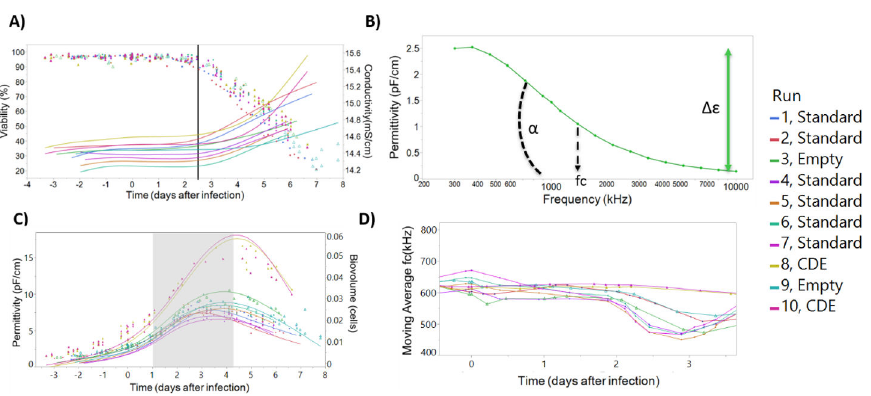
Figure 4. Incyte measurements can be correlated with the progress of baculovirus infection in insect cells. ( A ) The onset of baculovirus-induced cell lysis (viability, represented with circles) can be detected by the simultaneous onset of conductivity increase (smooth lines, measured by Incyte). ( B ) Beta-dispersion curve 24 h after seeding, for batch number 1. The beta-dispersion allows calculation of variables such as ∆ ε , α , and characteristic frequency, which are indicative of the cell state during the infection process. ( C ) Visual inspection of the permittivity profile allows to follow the three phases of the production process (separated by the shaded area): cell growth, cell diameter increase due to baculovirus infection, and baculovirus-induced cell lysis. Circles represent biovolume calculations based on the measured diameter and considering cells as perfect spheres, and smooth lines the Incyte permittivity measurements at 1000 kHz. ( D ) The characteristic frequency (frequency corresponding to the beta-dispersion curve inflection point) time profile is shown. The “v-shaped” profile after 2 days post infection has been postulated to be correlated with baculovirus release from cells elsewhere